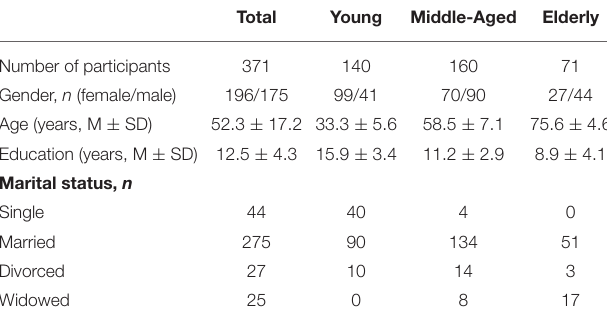
TABLE 1 | Demographic characteristics of the